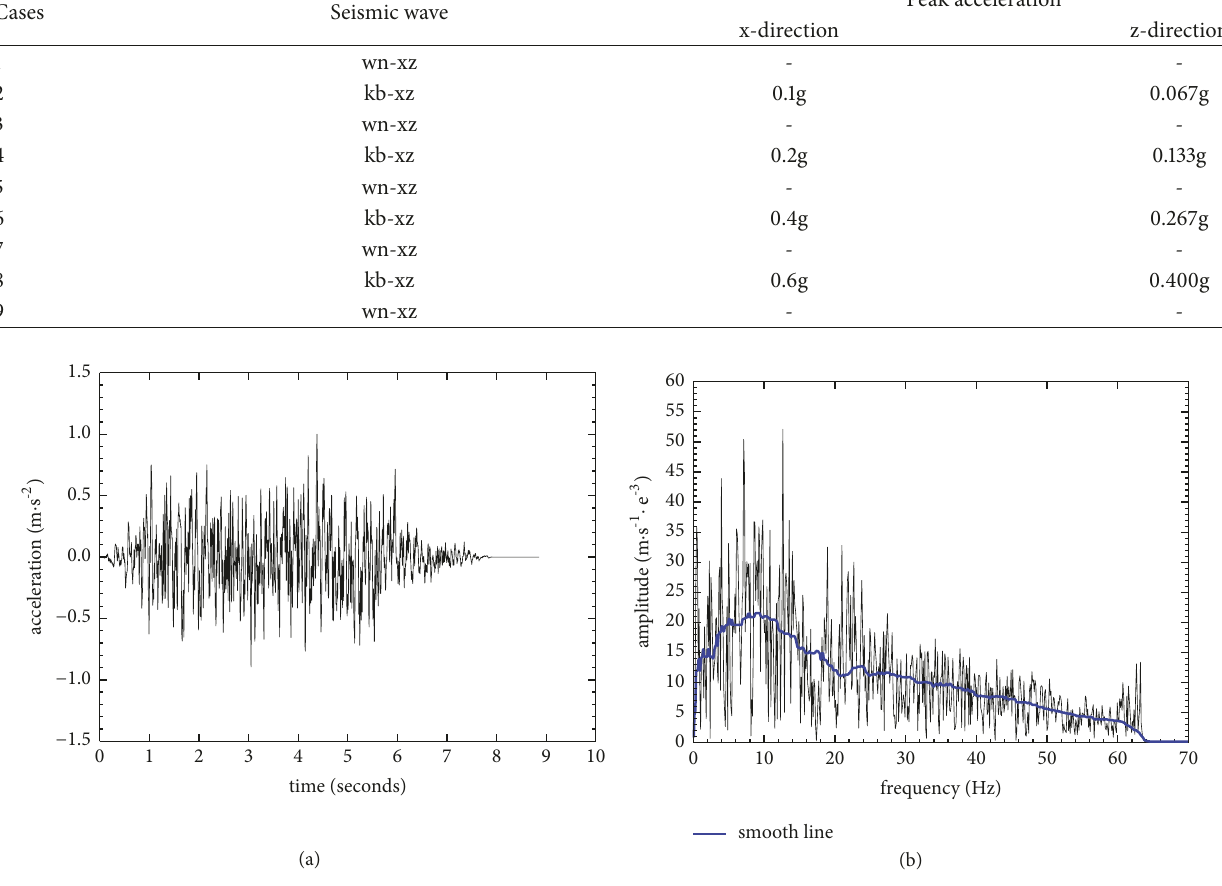
Figure 5: Kobe wave: (a) time history curve; (b) Fourier